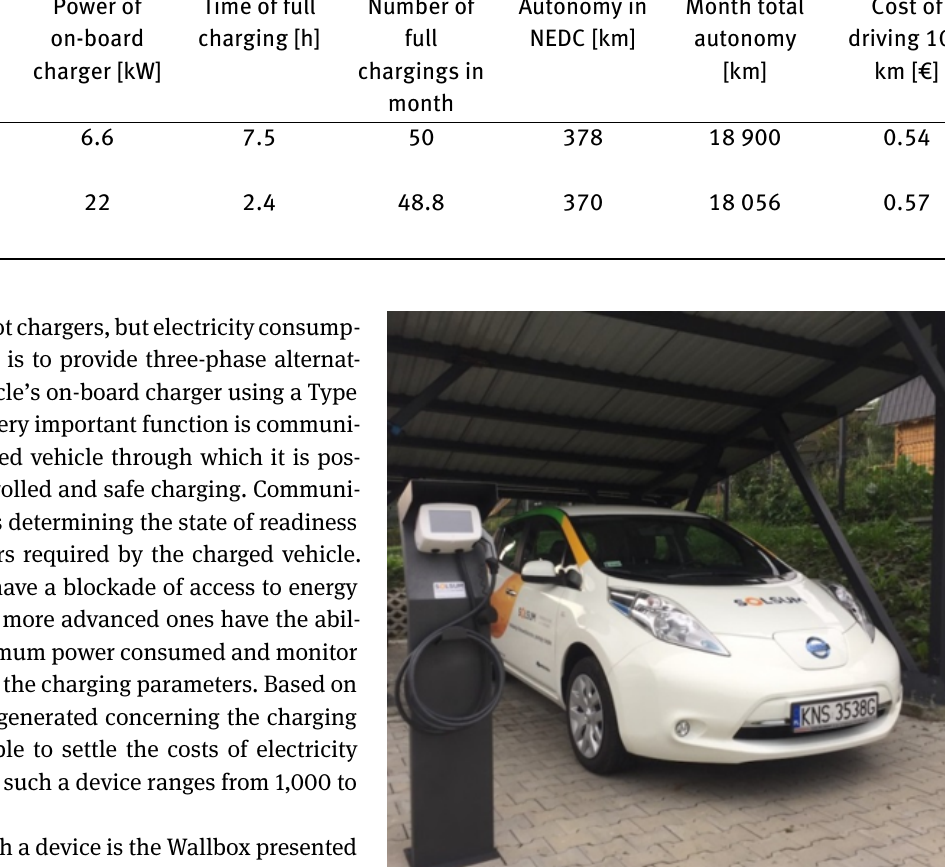
Figure 7: Wallbox with Nissan Leaf. Source: [35]